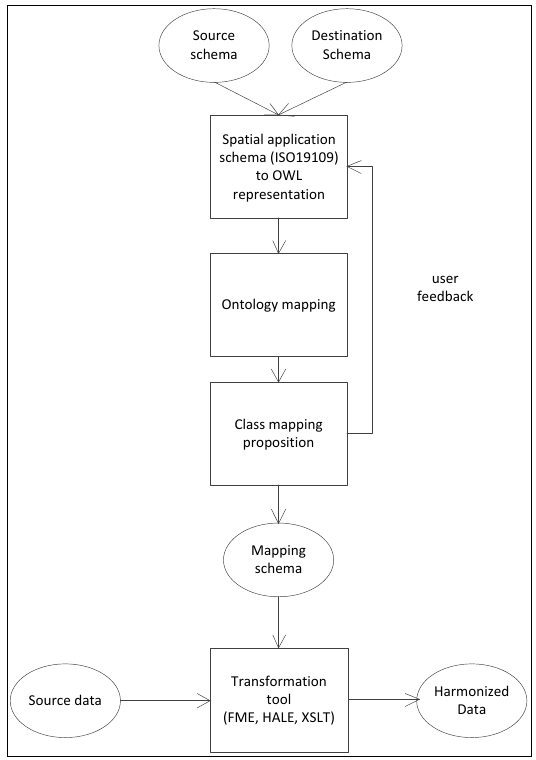
Figure 1. Proposed methodology